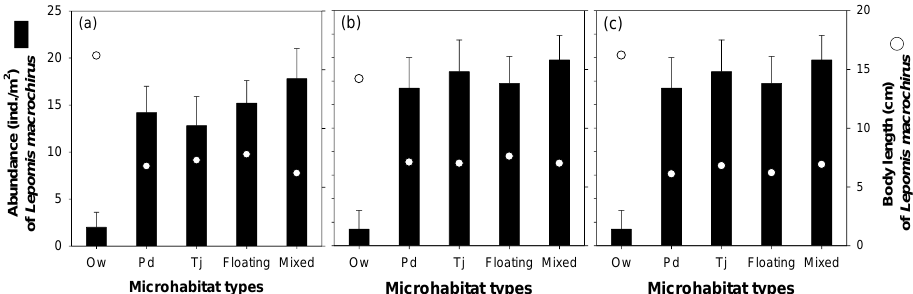
Figure 7. Lepomis macrochirus abundance according to five microhabitat types. Ow: open water; Pd: area covered by Paspalum distichum ; Tj: area covered by Trapa japonica ; Floating: area covered by floating-leaved macrophytes ( Hydrocharis dubia and Salvinia natans ); Mixed: area covered by floating-leaved and submerged macrophytes ( Hydrocharis dubia , Salvinia natans , Ceratophyllum demersum , Hydrilla verticillata , and Najas graminea ). in ( a ) Upo Wetland, ( b ) Jangcheok Wetland, and ( c ) Beongae Wetland. The consumption patterns of cladoceran species collected from each wetland differed according to the season (Figure 8).